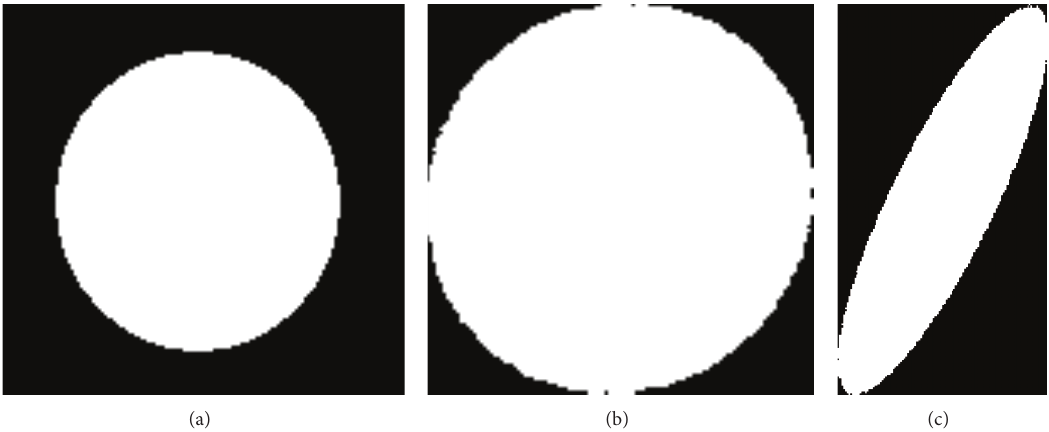
Figure 1: (a) An image of a circle. (b) A scaled version of circle in Figure 1(a). (c) An affine transformation version of circle in Figure 1(a).